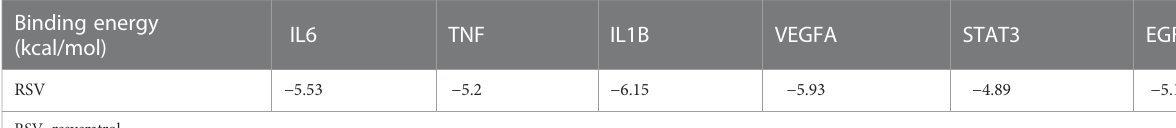
TABLE 2 The binding energy of RSV and the core targets. Binding energy (kcal/mol)